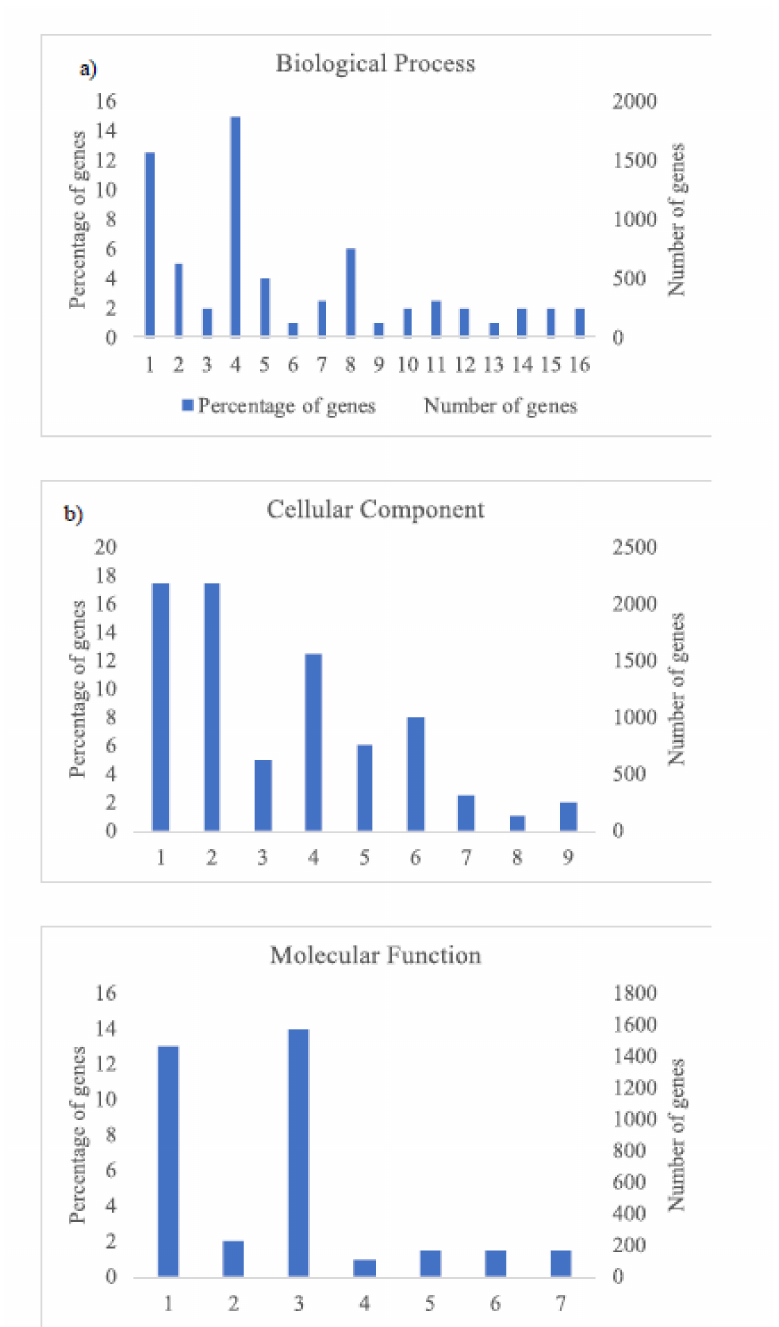
Figure 4. Histogram of GO classifications of L. perenne pollen in samples of 2018. Results are summarized for the three main categories: ( a ) Biological process: 1. Metabolic process, 2. Biological regulation, 3. Multi-organism process, 4. Cellular process, 5. Regulation of biological process, 6. Negative regulation of biological process, 7. Localization, 8. Response to stimulus, 9. Immune system process, 10. Signaling, 11. Cellular component organization or biogenesis, 12. Developmental process, 13. Positive regulation of biological process, 14. Multicellular organismal process, 15. Reproductive process, 16. Reproduction; ( b ) cellular component: 1. Cell, 2. Cell part, 3. Organelle part, 4. organelle, 5. Membrane part, 6. Membrane, 7. Protein-containing complex, 8. Membrane-enclosed lumen, 9. Extracellular region; and ( c ) molecular function: 1. Catalytic activity, 2. Transporter activity, 3. Binding, 4. Molecular transducer activity, 5. Molecular function regulator, 6. Structural molecule activity, 7. Transcription regulator